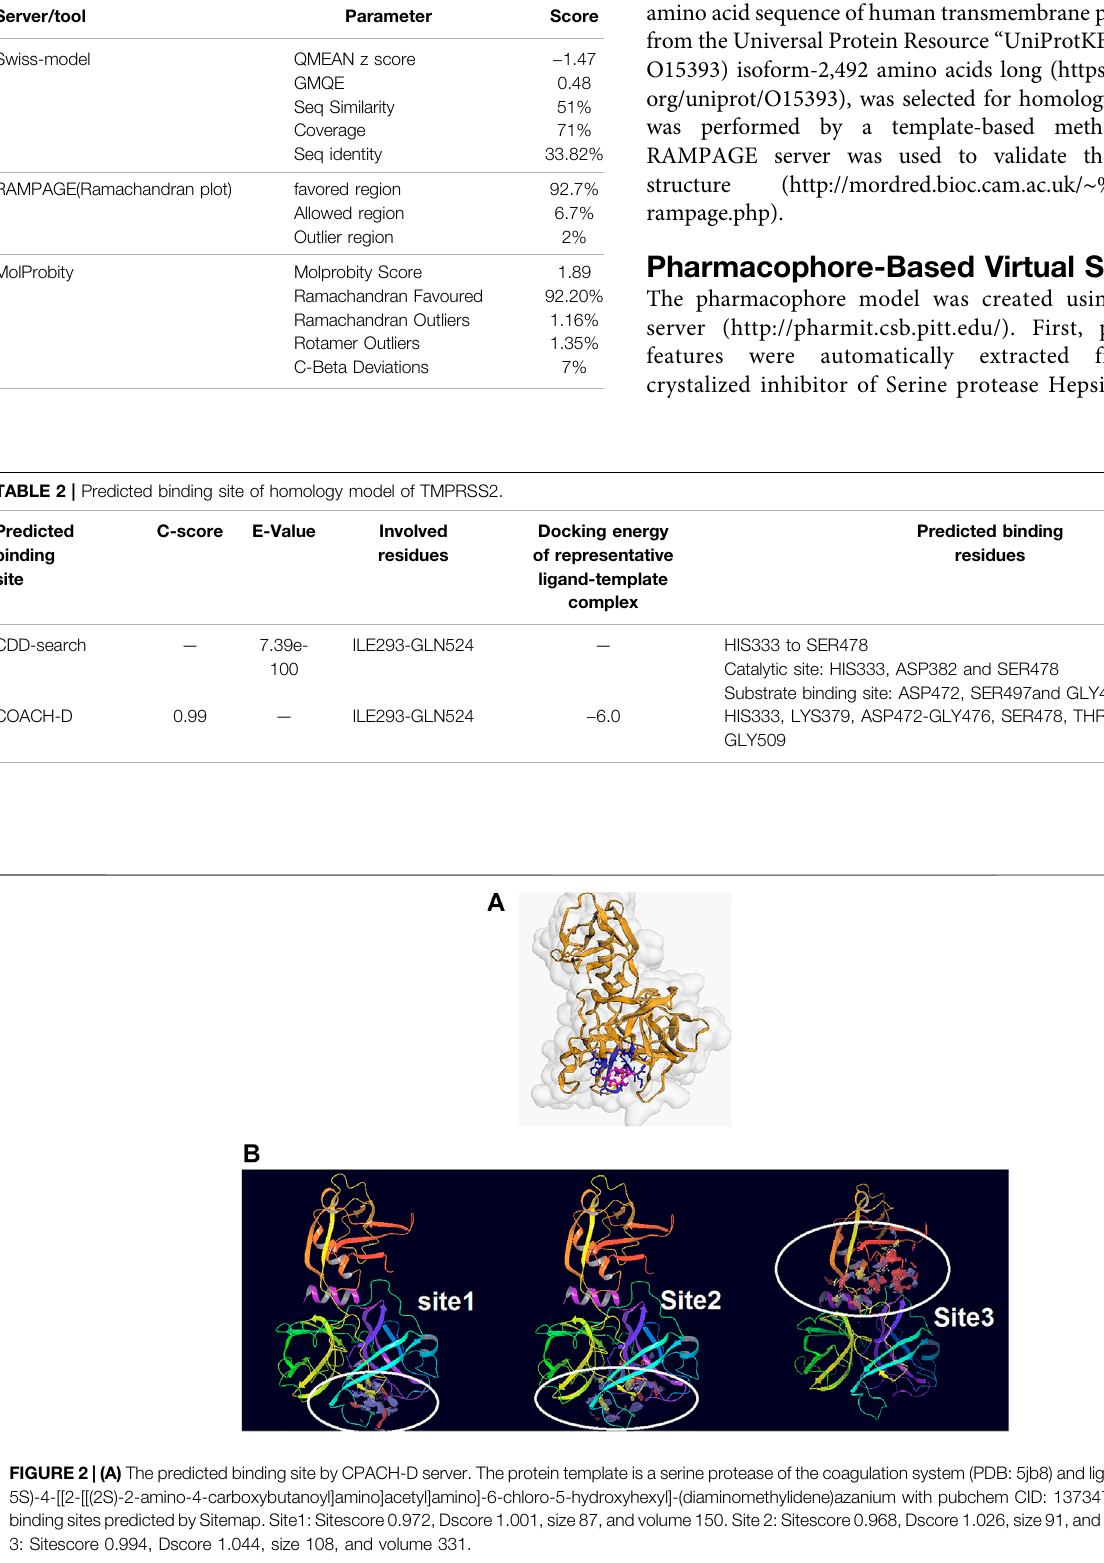
Frontiers in Chemistry |